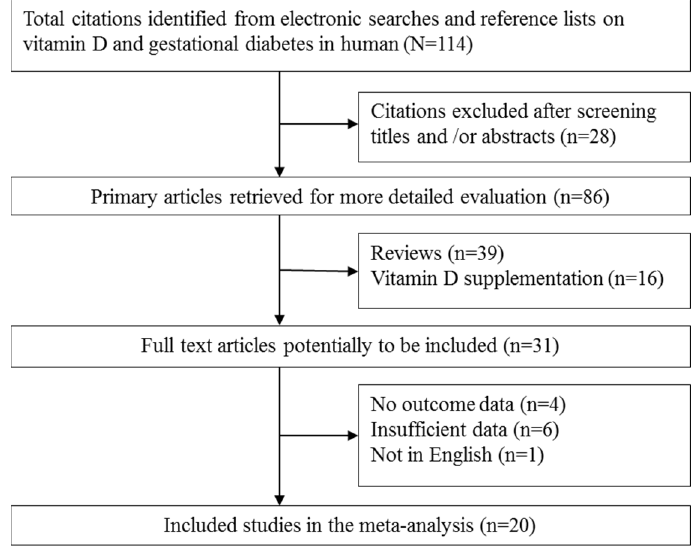
Figure 1. Flow chart of literature search and study selection.